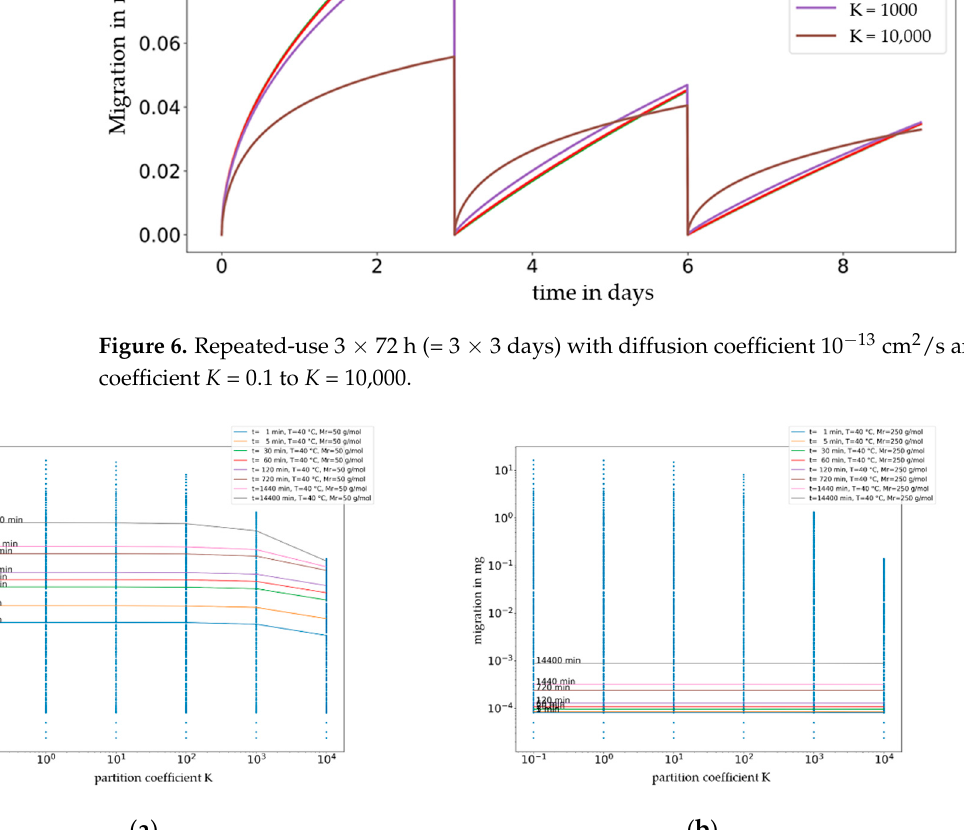
( d ) Figure 8. Single-use migration map for PET for contact times of 1 day ( a ) and 10 days ( b ) repeated-use migration map for contact times of 3 × 1 day ( c ) and 3 × 3 days = 9 days ( d ). Molecular weight in g/mol against temperature (T) in °C.